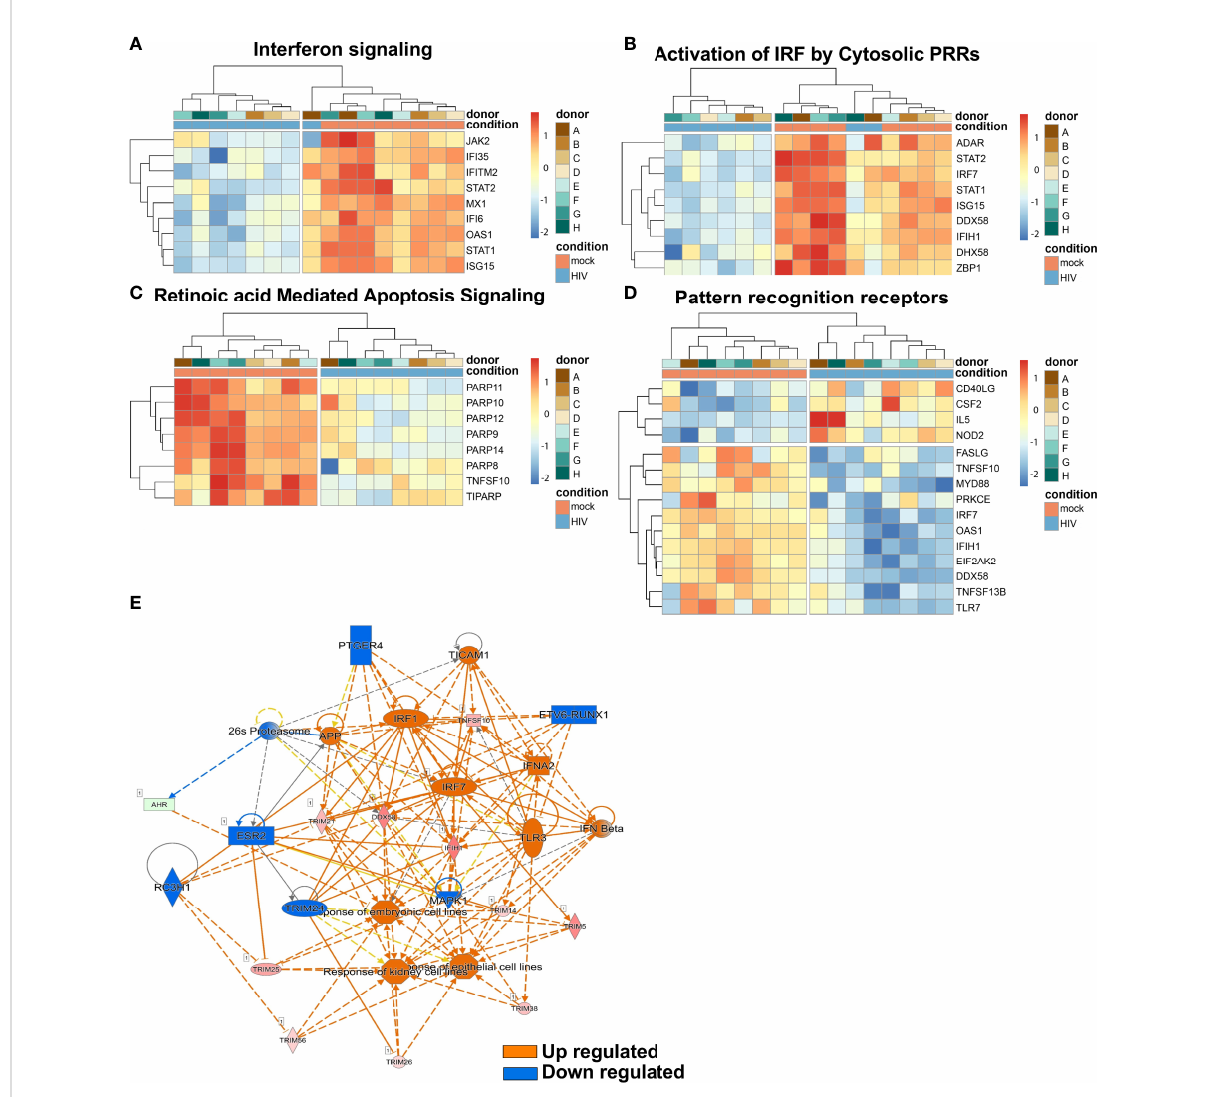
FIGURE 7 The top infection, in fl ammation, and immunology pathway regulators in HIV exposed DC cocultures. Transcriptomic data set of HIV exposed and unexposed DCs set including data from 8 individual donors/experiments was analyzed using pheatmap package to provide hierarchic clustered heatmaps of Interferon signaling (A) , Activation by Cytosolic PRRs (B) , Retinoic Acid Mediated Apoptosis Signaling (C) and Pattern recognition receptors (D) pathways with genes recognized in IPA to belong to these pathways. Transcriptomic data set from 8 individual donors/experiments was analyzed for Pathway regulators limited to infection, in fl ammation and immunology and were visualized as network with a threshold for p-values set to -log 1.3 (p<0.05) and presented as positive activation Z-score in orange and negative in blue (E)